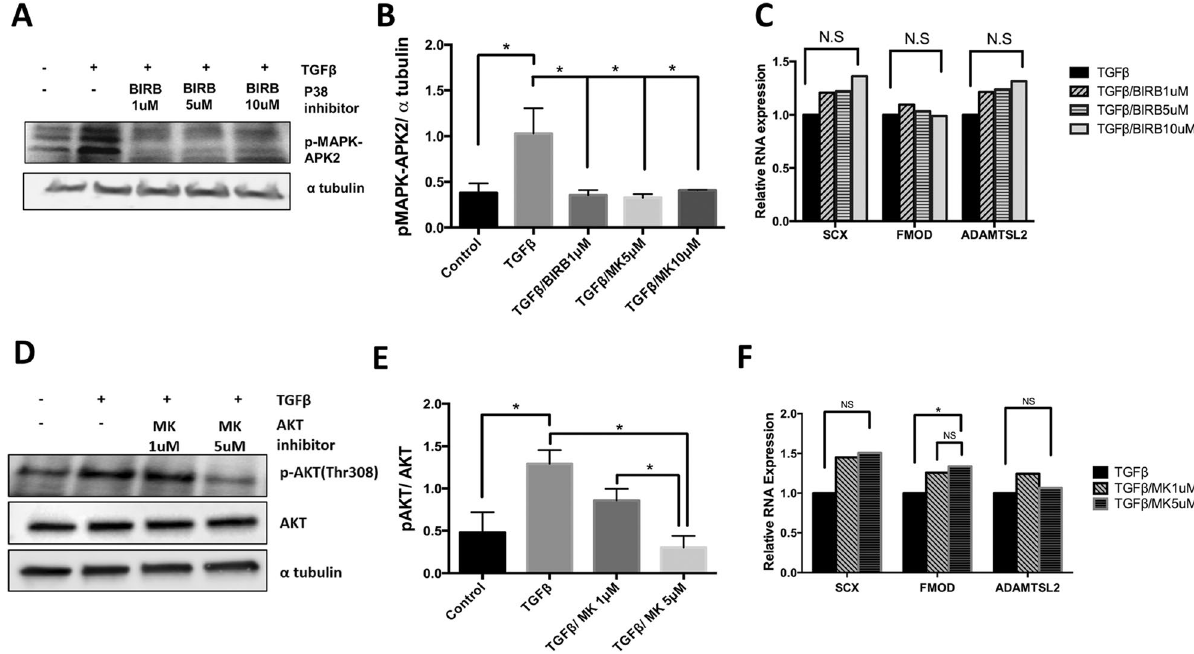
Figure 4. AKT and p38 are not required for TGF-β-mediated regulation of fibrous tissue markers. ( A ) Sclerotome was treated with varying concentrations (1 µM, 5 µM, 10 µM) of P38 inhibitor, BIRB, for 24 h and then treated with TGFβ1 for 8 h. Immunoblot was used to determine relative levels of the p38 target, p-MAPK- APK2. α-tubulin was used as a loading control. ( B ) p-MAPK-APK2 levels were quantified using Image J and GraphPad Prism. (*) indicates significance, p < 0.05, n = 3. ( C ) RNA was isolated from cells treated with BIRB and TGFβ1 as indicated. qPCR was used to measure the relative expression of Scx, Fmod, and Adamtsl2. mRNA levels were normalized to the housekeeping gene HPRT. Expression is shown relative to the TGFβ1 treated control. Results were analyzed with REST. (*) indicates significance, p < 0.05, n = 3. ( D ) Sclerotome was treated with varying concentrations (1 µM, 5 µM) of AKT inhibitor, MK, for 24 h and then treated with TGFβ1 for 8 h. Immunoblot was used to measure relative levels of pAKT and total AKT. α-tubulin was used as a general control. ( E ) Immunoblots were scanned using Image J and quantified. Activation of AKT was measured as pAKT over total AKT. (*) indicates significance, p < 0.05, n = 3 ( F ) mRNA was isolated from cells treated with MK and TGFβ1 as indicated. qPCR was used to measure the relative levels of Scx, Fmod, or Adamtsl2 mRNA. All mRNA levels were normalized to the housekeeping gene HPRT. Expression is shown relative to the TGFβ1 treated samples. Results were analyzed with REST. (*) indicates significance, p < 0.05, n = 3. Detailed results from qPCR REST analysis are shown in Tables S7, S8. Immunoblots were cropped for clarity. Examples of uncropped blots are found in Supplementary